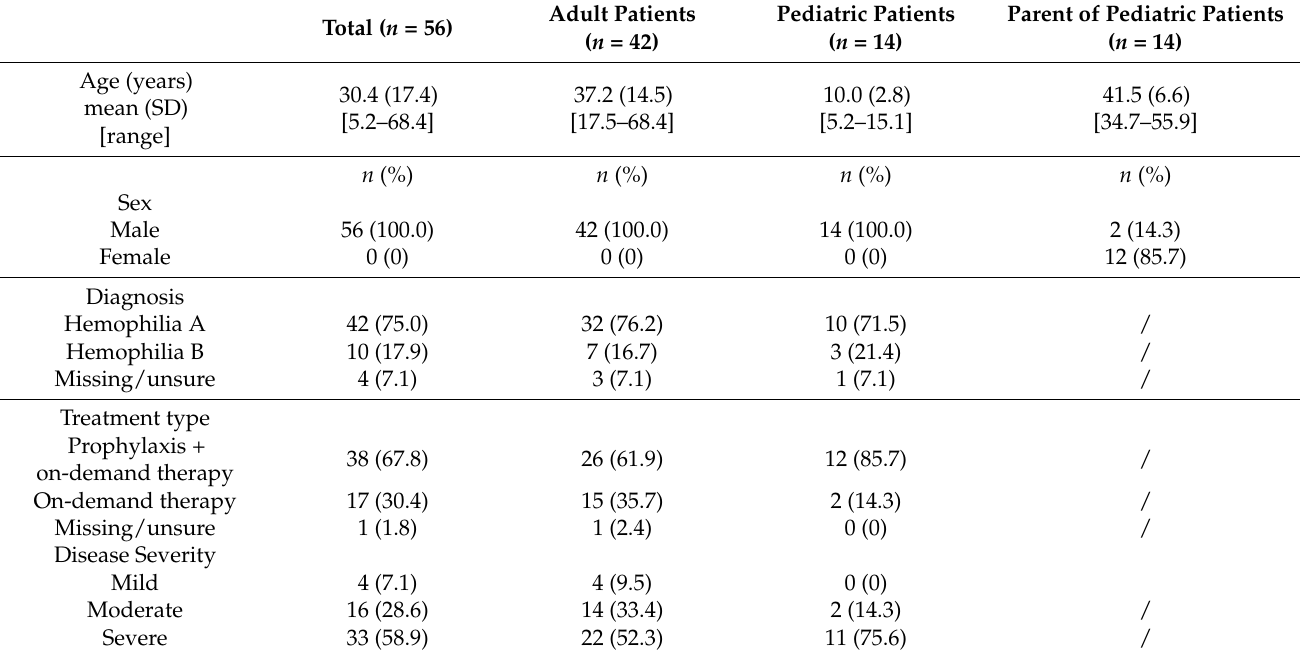
Table 1. Demographics and Clinical Characteristics of Study